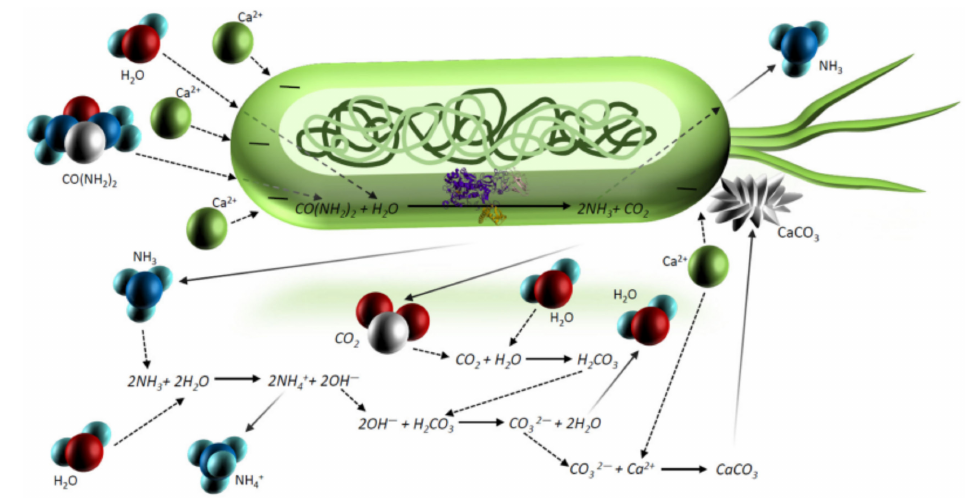
Figure 1. A representation of calcite precipitation due to the MICP method